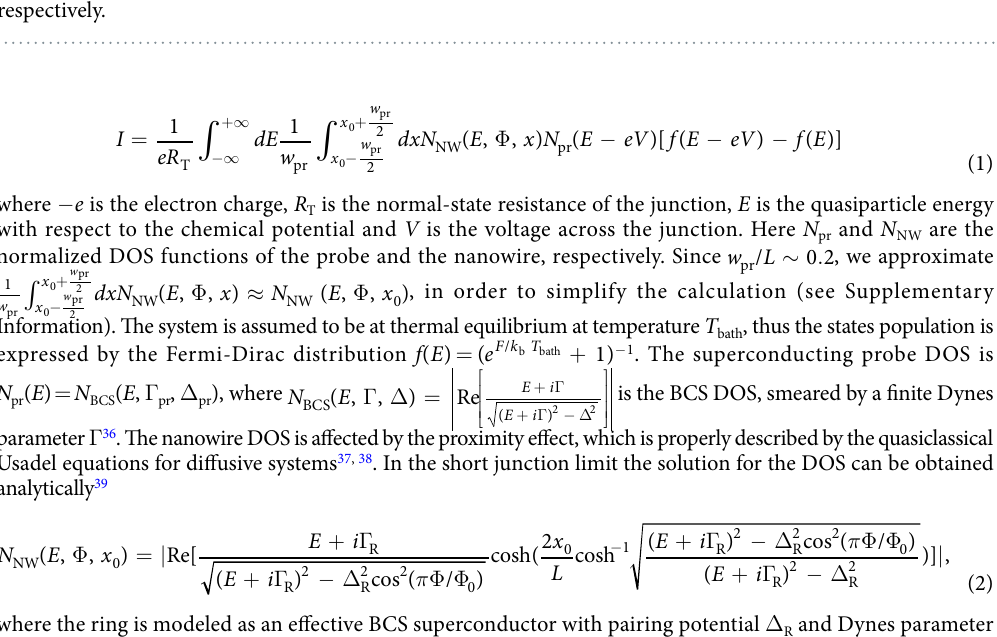
Figure 3. Interferometric behaviour of the V-based SQUIPT (sample-A) at T bath = 25 mK. ( a ) Current modulation I ( Φ ) for different values of the bias voltage V b applied to the tunnel junction. ( b ) Voltage modulation curves V ( Φ ) at different values of the bias current I b through the junction. ( c ) and ( d ) Flux- to-current dI / d Φ and flux-to-voltage dV / d Φ transfer functions, obtained differentiating I ( Φ ) and V ( Φ ),